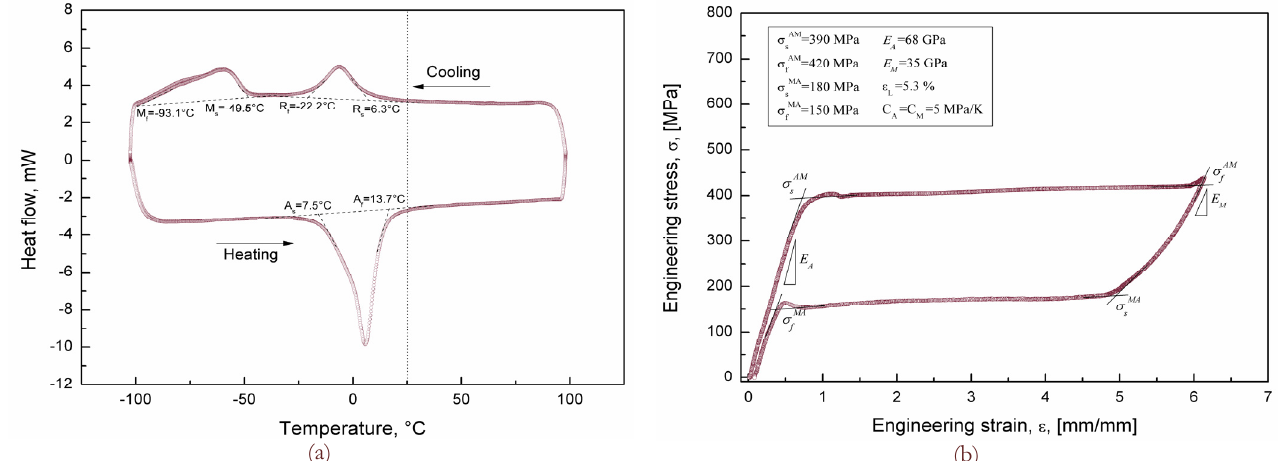
Figure 1: Thermo-mechanical properties of the alloy investigated: a) DSC thermograph with transformation temperatures and b) Loading-unloading isothermal stress-strain cycle (298